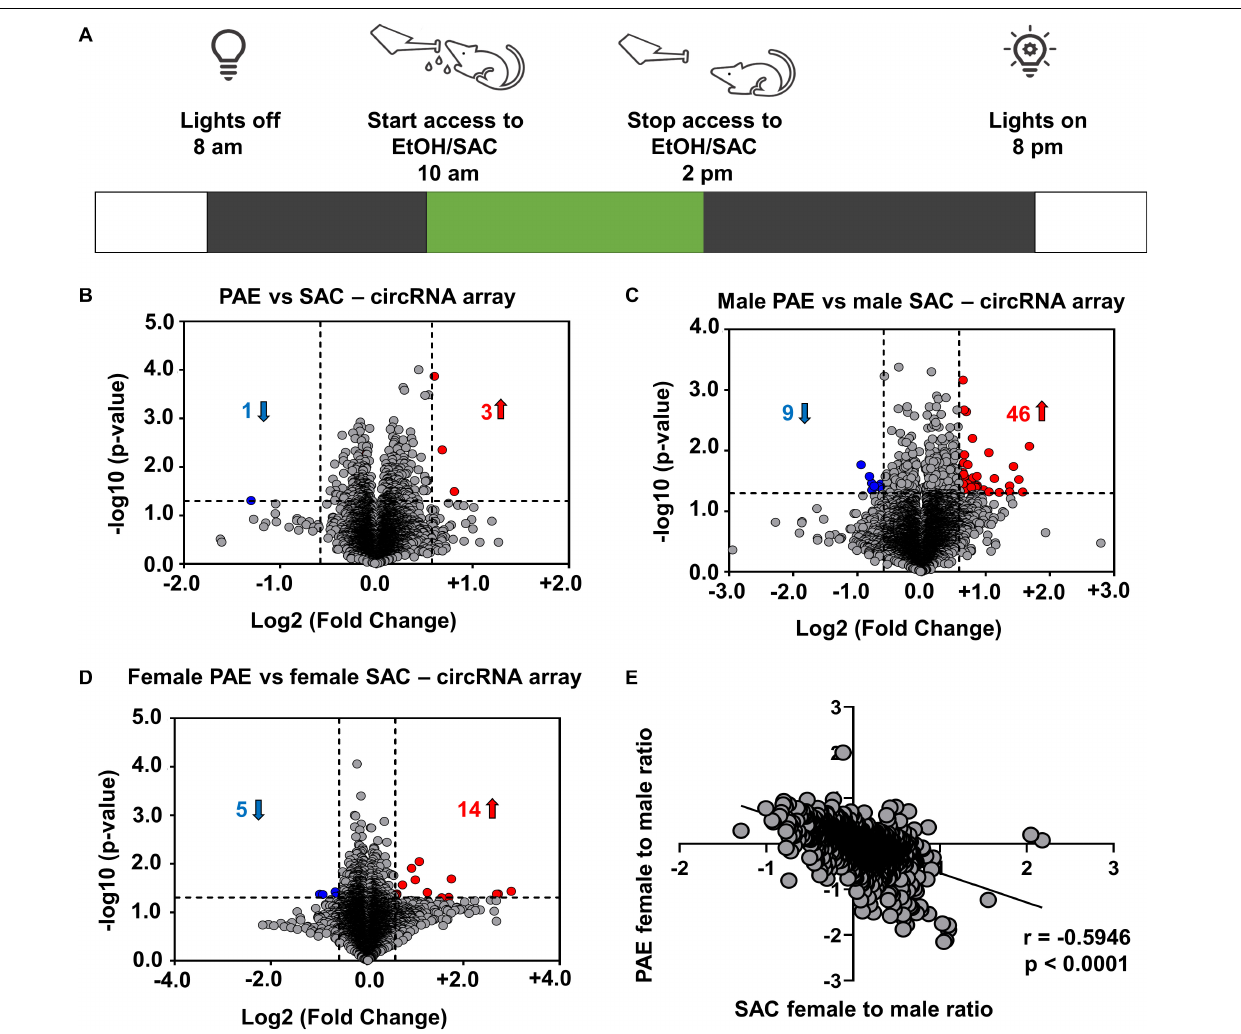
FIGURE 1 | Changes in circRNA expression in embryonic brain following PAE display sex dimorphism. (A) Schematic representation of “drinking in the dark” PAE model of FASD. As described above, female mice were subjected to voluntary drinking of either 0.066% (w/v) saccharin sweetened solution (control) or 10% (w/v) ethanol in 0.066% (w/v) saccharin sweetened solution for 4 h/day during mating and throughout the gestational period. (B) Volcano plot showing overall fold changes in the 10,000 most abundant circRNAs in PAE ( N = 6 with half being male and half female) compared to SAC (control) E18 whole brain ( N = 6 with half being male and half female). Overall, only 3 circRNAs were upregulated and 1 circRNA was downregulated (1.5-fold changes, p < 0.05). (C) Volcano plot showing fold changes in circRNAs expression in male PAE compared to male SAC E18 whole brain. 46 circRNAs were upregulated and 9 circRNAs were downregulated with 1.5-fold changes ( p < 0.05). (D) Volcano plot showing fold changes in circRNAs expression in female PAE compared to female SAC E18 brain. 14 circRNAs were upregulated and 5 circRNAs were downregulated with 1.5-fold changes ( p < 0.05). In all volcano plots (B–D) , X-axis represents log2 fold change (dotted line = 1.5-fold), Y-axis represents –log10 p -value (dotted line: p = 0.05). (E) Spearman correlation of female to male ratio for each circRNA in either control SAC (female SAC vs. male SAC) or PAE (female PAE vs. male PAE). A robust negative correlation (Spearman correlation coefficient r = –0.5946, two-tailed p -value p < 0.0001) was observed between female to male ratios in SAC and PAE